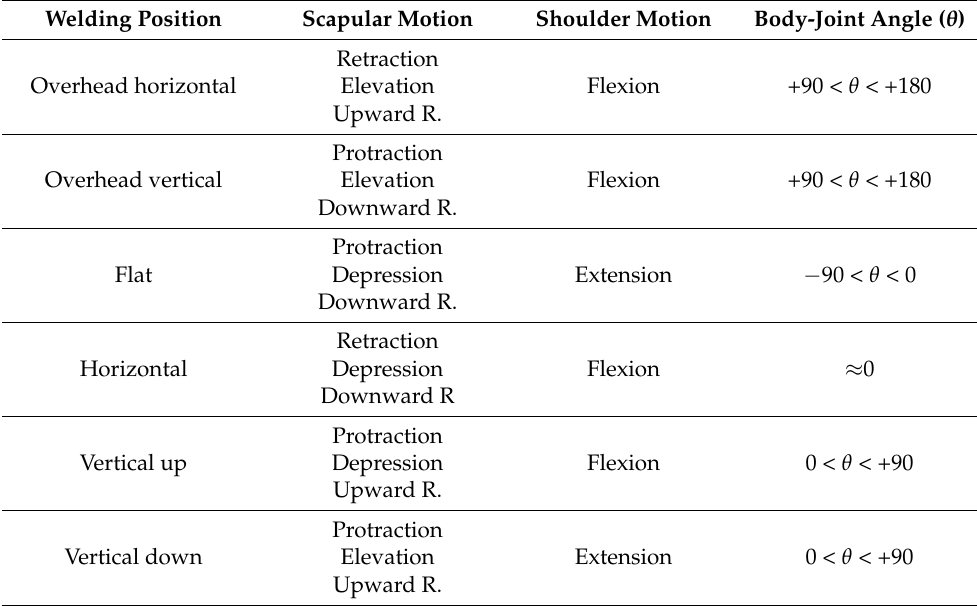
Flexion +90 < θ < +180 Extension − 90 < θ < 0 Flexion ≈ 0 Flexion 0 < θ < +90